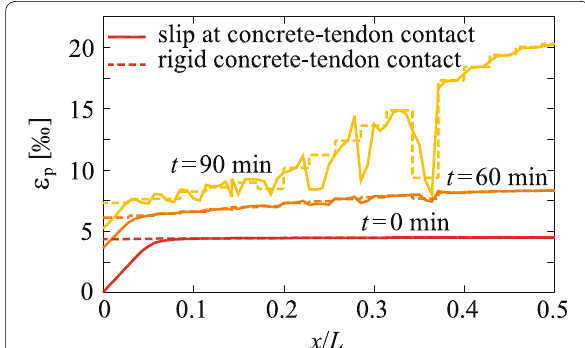
Fig. 16 The distributions of extensional strains in the tendon along the beam at different simulation